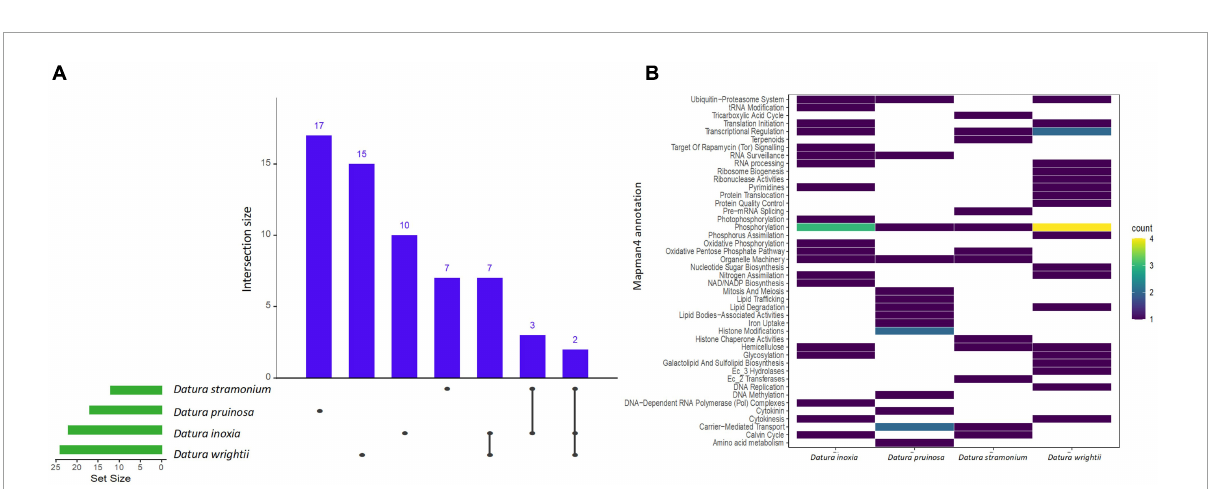
FIGURE3 UpSet plot shows the intersections of the set of a particular protein family annotated Mapman4 with signal of physicochemical divergence from the seven transcriptomes. Filled cells indicate that the set is participating in the intersection and that the species share that protein family with signal of physicochemical divergence (A) . Heatmap of the enriched proteins with signal of physicochemical divergence of the four Datura species studied here (B) . The brightness of color indicates the number (counts) of enriched protein families with signal of physicochemical divergence that are shared between species. See also Supplementary Table 5